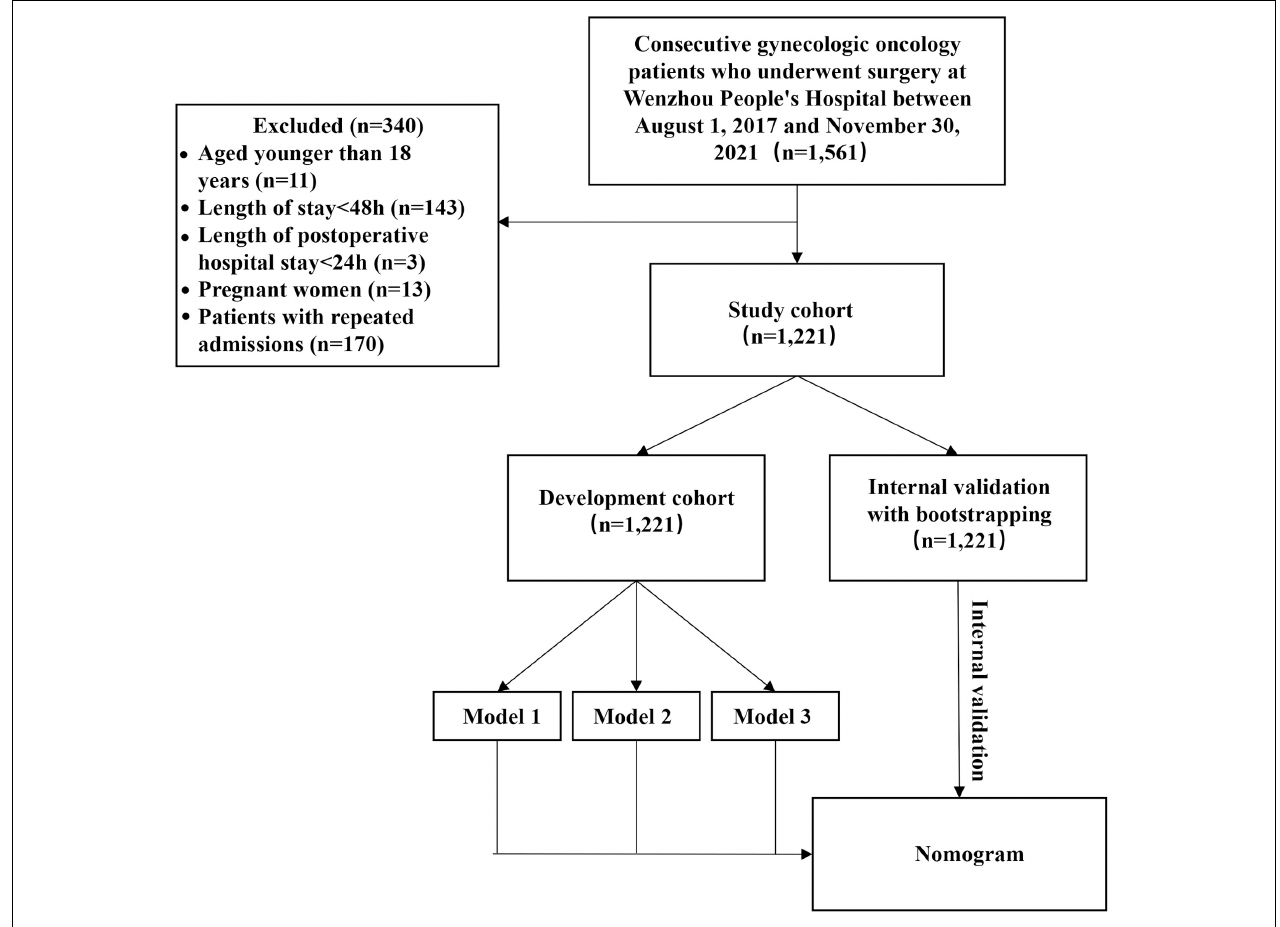
FIGURE 1 | Flow chart of the study